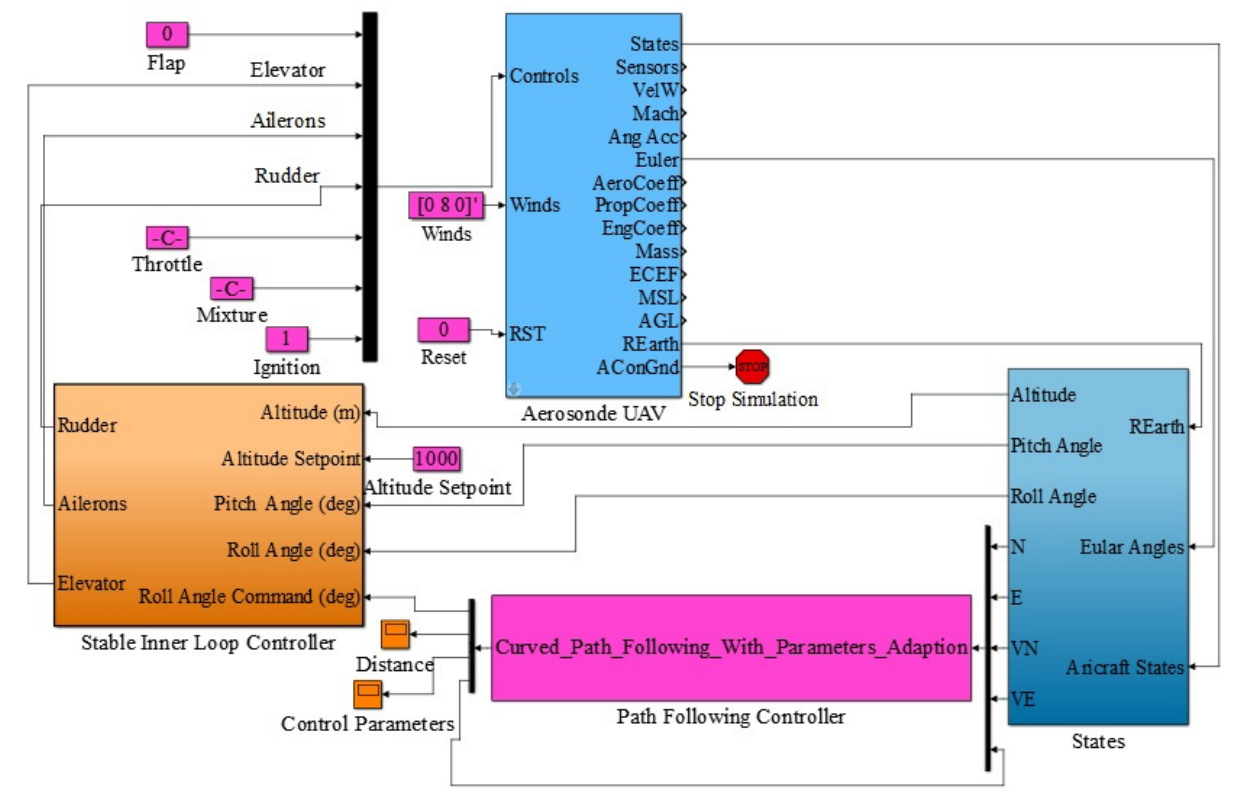
Figure 9. The simulation in the Matlab/Simulink environment. Table 2. The parameters for simulation.